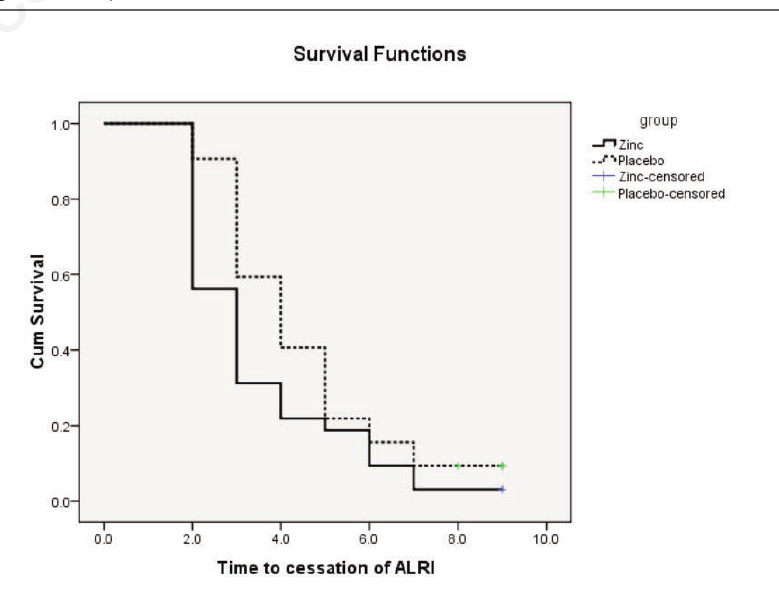
Figure 2 Kaplan-Meier survival curves for time to cessation of acute lower respiratory tract infection